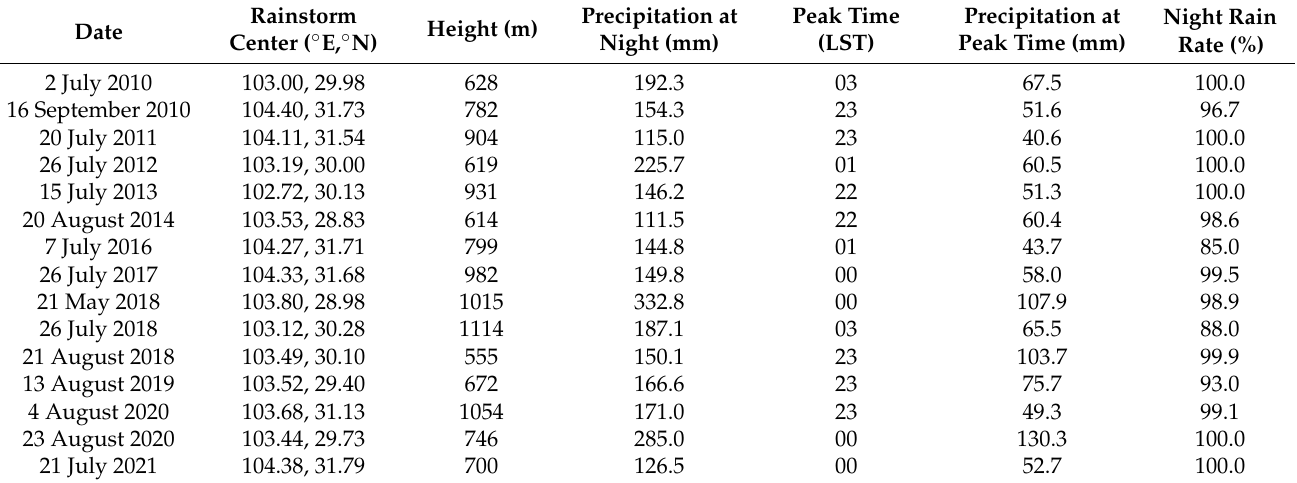
Table 1. Statistics of nocturnal rainstorm cases during 2010–2021 in western